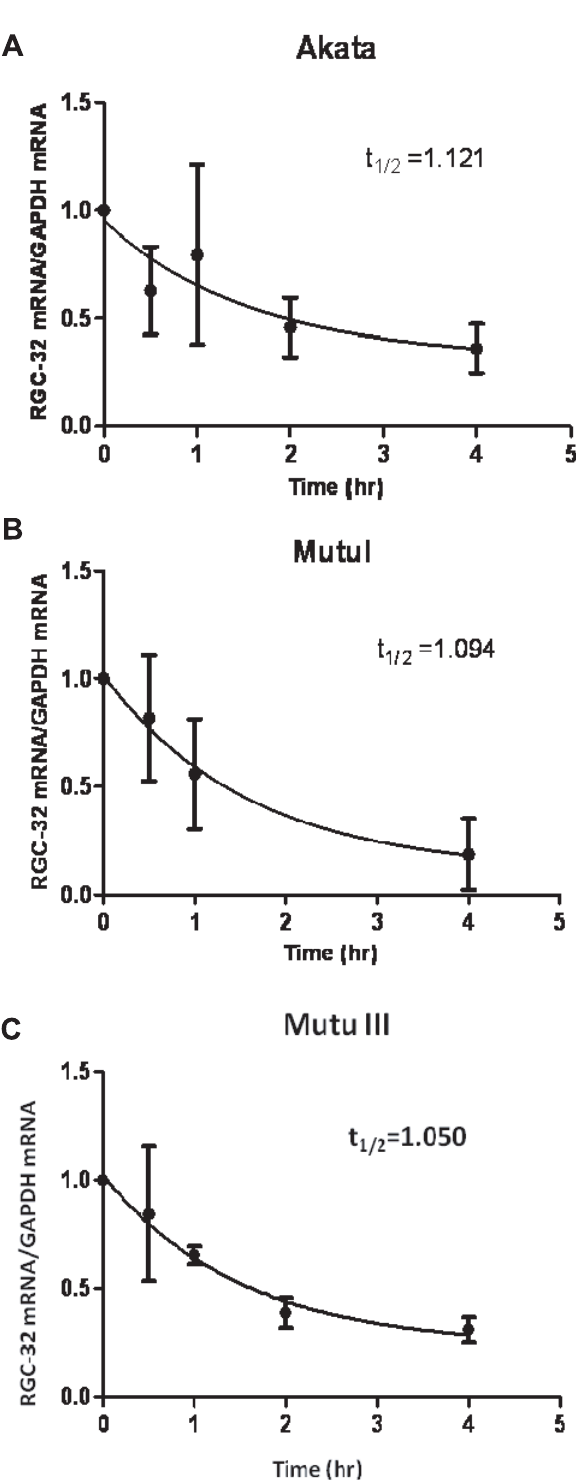
Figure 6. RGC-32 mRNA is not stabilized in latency I cell lines. Cell-lines were treated with Actinomycin D and samples analysed at the times indicated. RGC-32 mRNA levels were deteremined by Q-PCR and normalized to those of the stable control message GAPDH. Results are expressedrelative tothelevel detectedat time 0 andshowthe mean + / 2 standard deviation of 4 independent experiments for Akata (A) or two independent experiments for Mutu I (B) and Mutu III cells (C). The half-life values indicated were calculated using non-linear regression analysis.